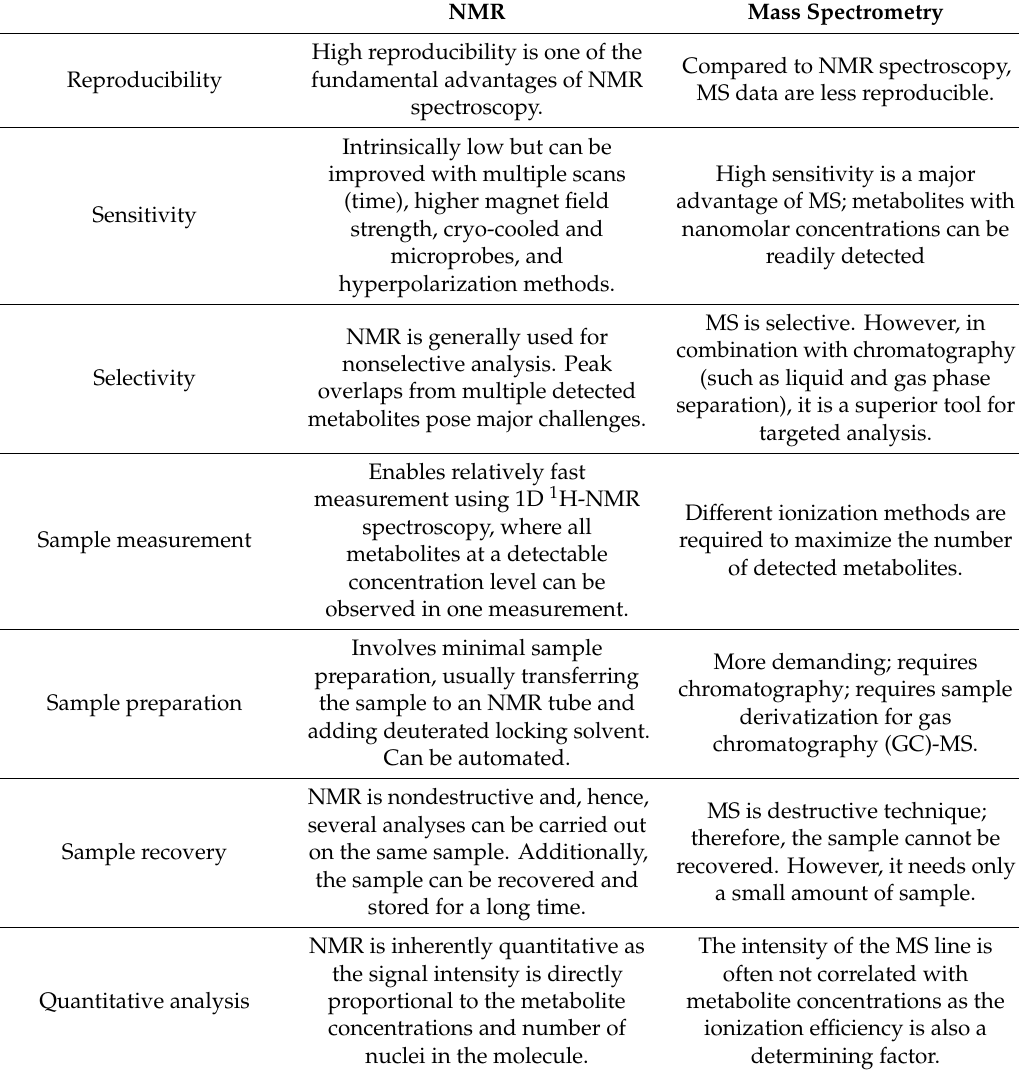
Table 1. Summary of the most important advantages and limitations of nuclear magnetic resonance (NMR) spectroscopy compared to mass spectrometry (MS) in metabolomics